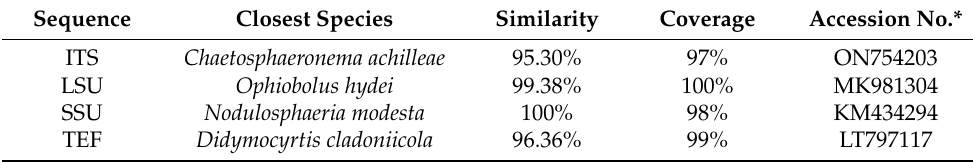
Table 3. Sequence similarities with their closest-known species of strain